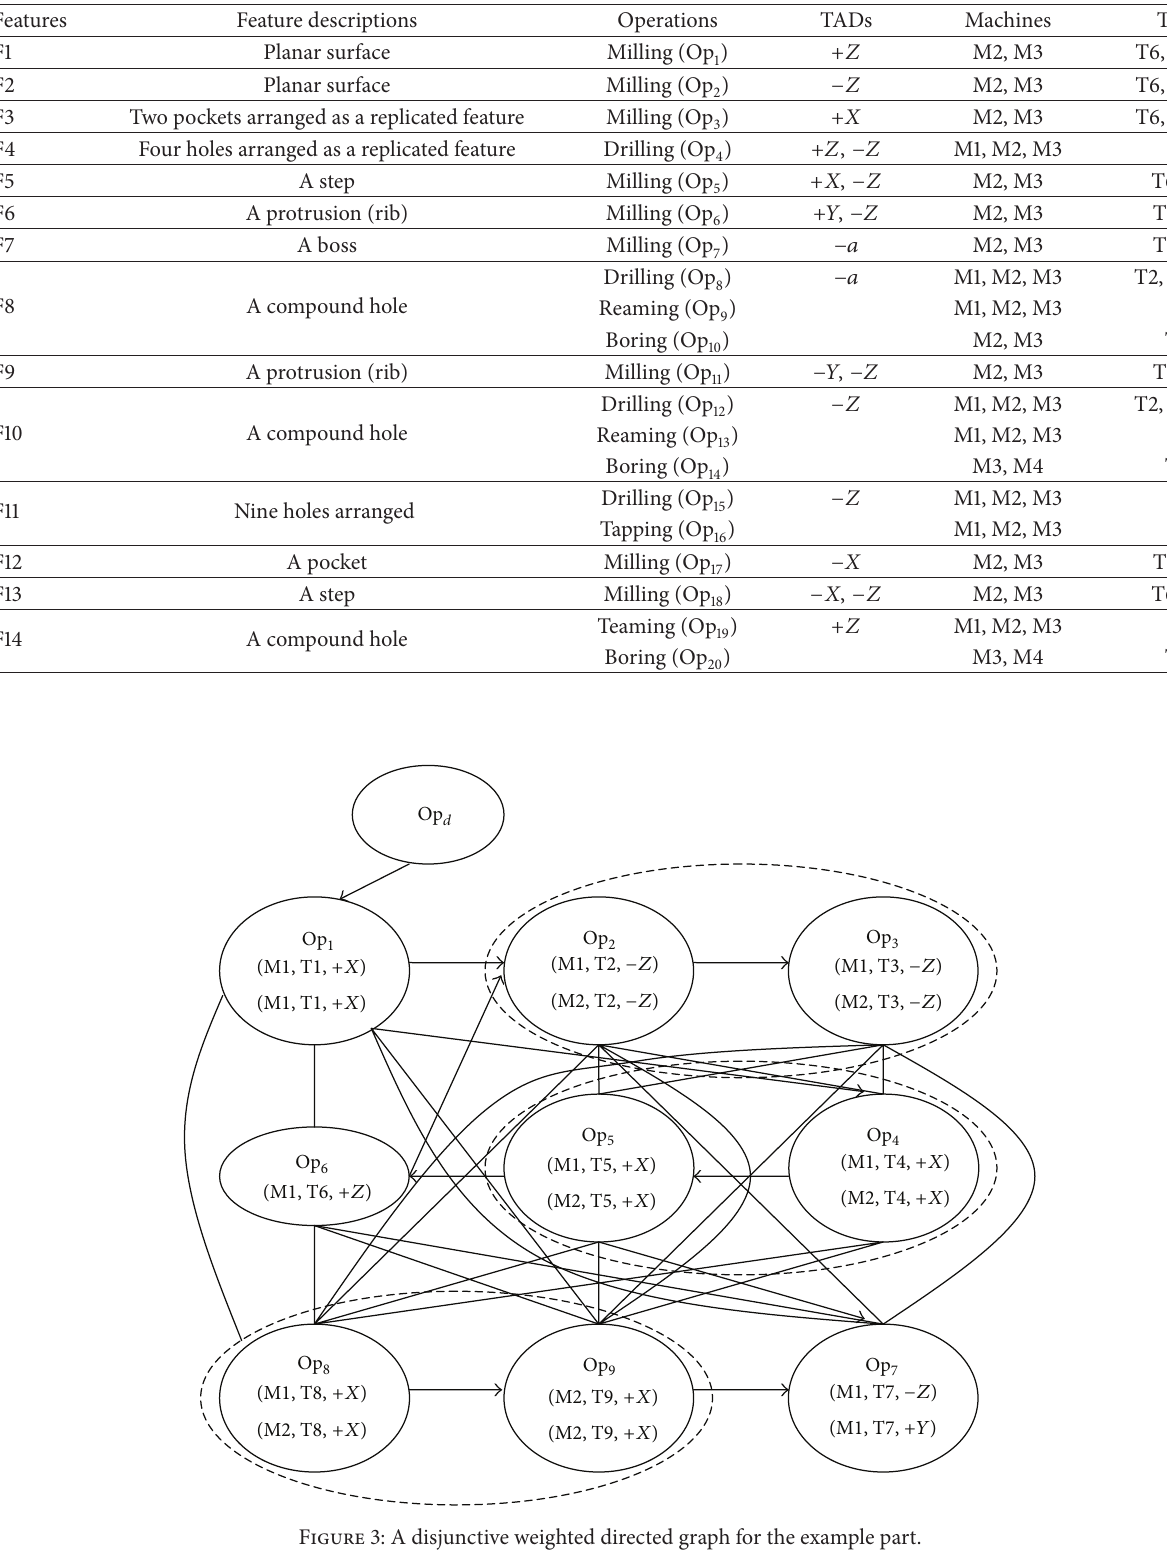
Table 7: Features, operations, and machining information of the sample part.